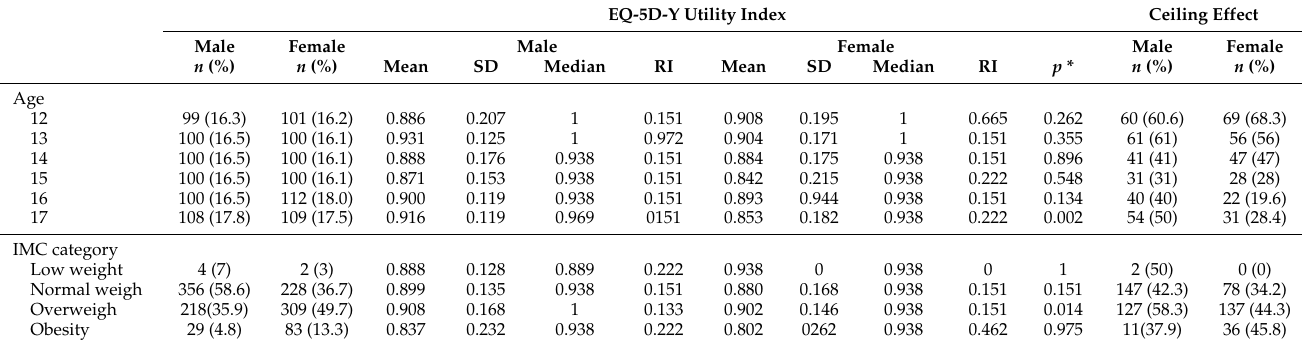
Table 2. Study sample characteristics. EQ-5D-5L adolescents’ population normative values by gender. EQ-5D-Y Utility Index